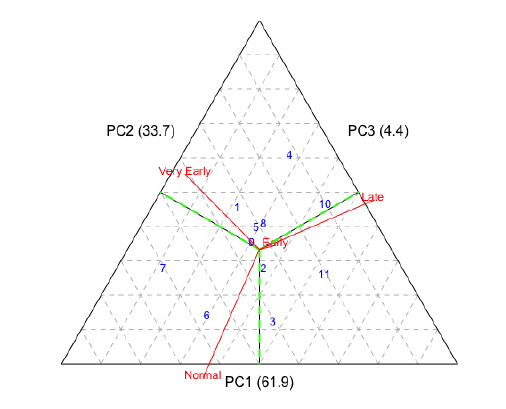
Figure 2: AMMI 1 triplot for yield (ton ha-1) of 11 potato genotypes and four planting dates using genotypic and environmental scores. (Where